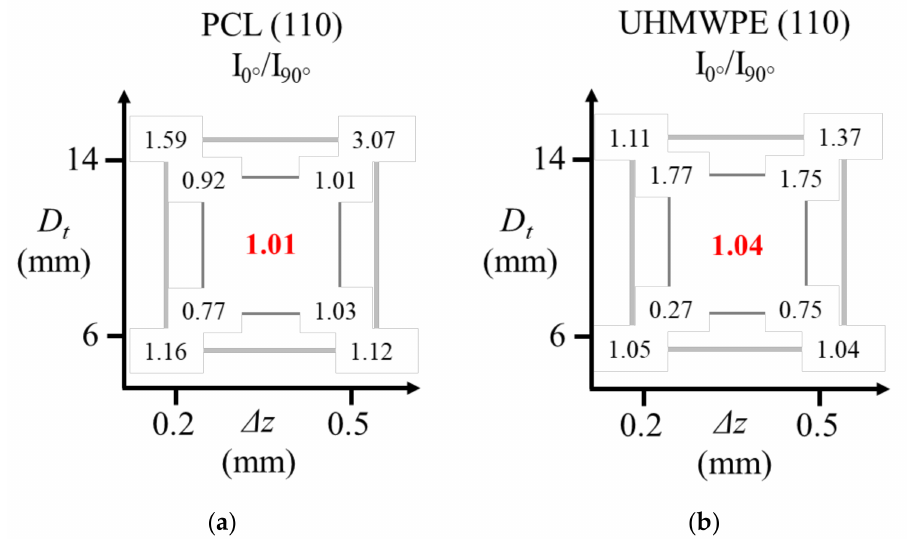
Figure 20. Values of the ratio I 0 / I 90 for the diffraction peak associated to the (110) plane ( a ) PCL; ( b ) UHMWPE; where I 0 is the maximum intensity in the measurement at 0 ◦ and I 90 is the maximum intensity in the measurement at 90 ◦ according to the experimental setup described in Figure